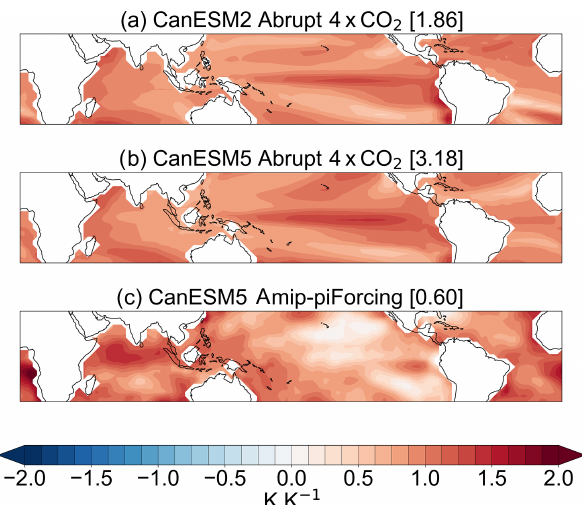
Figure A4. Tropical SST response for the (a) CanESM2 abrupt 4 × CO 2 simulation, (b) CanESM5 abrupt 4 × CO 2 simulation, and (c) CanESM5 AMIP-piForcing simulation. Responses are defined as the difference between 20-year means taken from the beginning and end of each simulation. All grid box values are divided by the global mean response for each respective simulation, which is shown in square brackets in each subplot